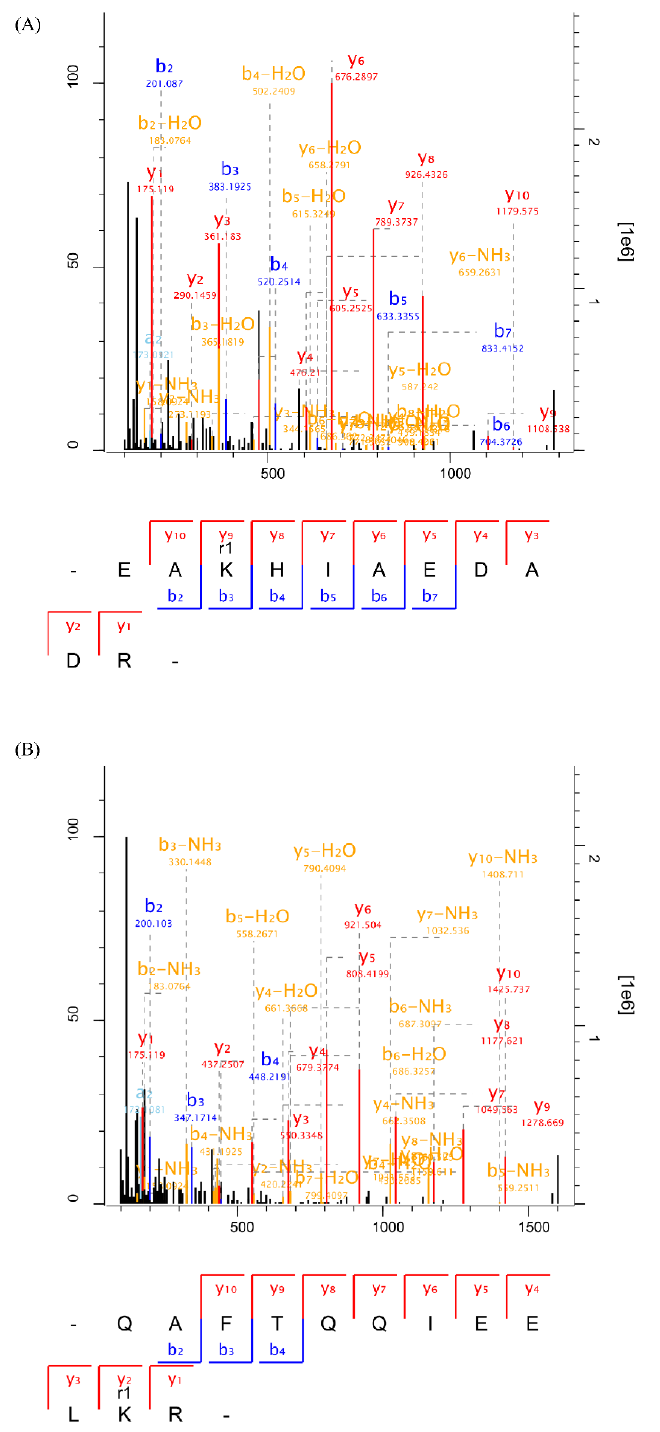
Figure 6. Representative MS/MS spectrums of MDA-modified peptides. ( A ) The peptide modified with the formation of Schiff base adduct at lysine (K); ( B ) the peptide modified with the formation of DHP adduct at lysine (K).